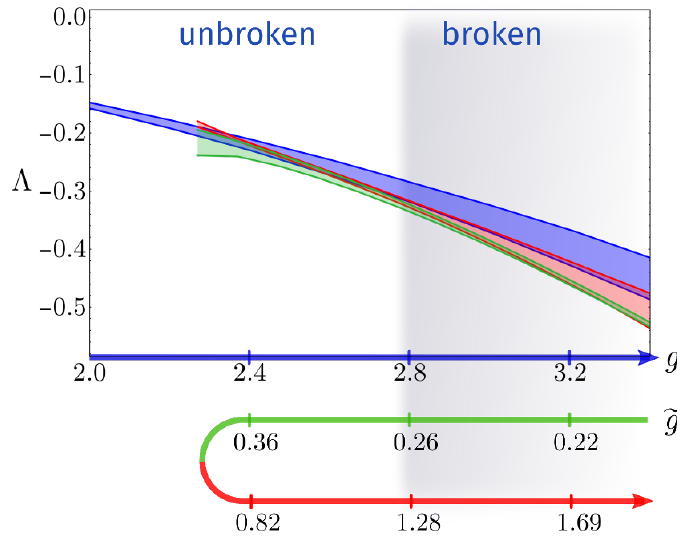
Figure 7 . The vacuum energy (cid:3) for the theory described by the Lagrangian (2.1) as a function of the coupling constants g (blue), g ( w ) (green) and g ( s ) (red). The blue band is computed by resumming the series in the unbroken phase (conformal mapping as in ref. [1]). The green band is obtained via Chang duality from the weak branch of the broken phase (conformal mapping in e e eq. (3.6))). The red band is obtained via Chang duality from the strong branch using the EPT series in eq. (4.8) (conformal mapping as in ref.